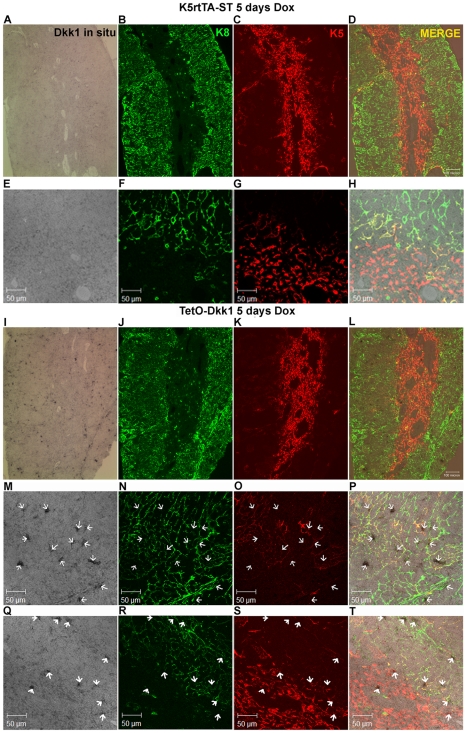
Doxycycline-regulated expression of the DKK1 transgene is evident in
both cTECs and mTECs in the adult thymus.Following a 4-week Dox induction, 12 µm frozen thymic sections
were prepared from ST control and TetO-Dkk1 mice and subjected to
in situ hybridization with a DKK1 specific probe
followed by detection with Sections were then counterstained with
anti-Keratin 8 and anti-keratin 5 antibodies to allow localization the
DKK1 expression to specific thymic regions and to cortical and medullary
TEC subsets. Each row of photos shows in situ
hybridization with a DKK1 specific probe followed by Immunofluorescent
staining with K8 (green), K5 (red) and a merge of all three. K5rtTA-ST
control lobes show little endogenous DKK1 expression at 100X
(A–D) or 400X (E–H).
In contrast, Dox induction resulted in widespread transgenic expression
of DKK1 in the TetO-Dkk1 mice with positive TECs being more abundant in
the K8 dominated cortex than the K5 dominated medulla when examined at
100X (I–L). High magnification examination of the
thymic cortex of TetO-Dkk1 mice revealed that a high percentage of
K5K8DP and a smaller number of K8+ cTECs exhibited strong DKK1
transgene expression. White arrows in all panels identify
DKK1-expressing TECs, thus allowing characterization of the keratin
profile (M–P). Surprisingly, more limited
transgenic DKK1 expression was evident in the medulla, with a small
percentage of the K5-expressing mTECs and a higher frequency of the
K5K8DP TECs at the cortico-medullary junction expressing DKK1
(Q–T).